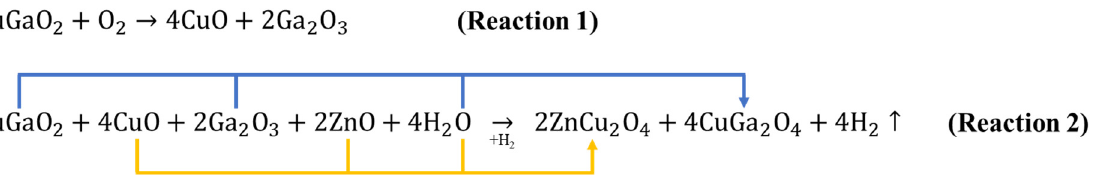
Figure 4. Reactions for possible formations of ZnCu 2 O 4 and CuGa 2 O 4 .